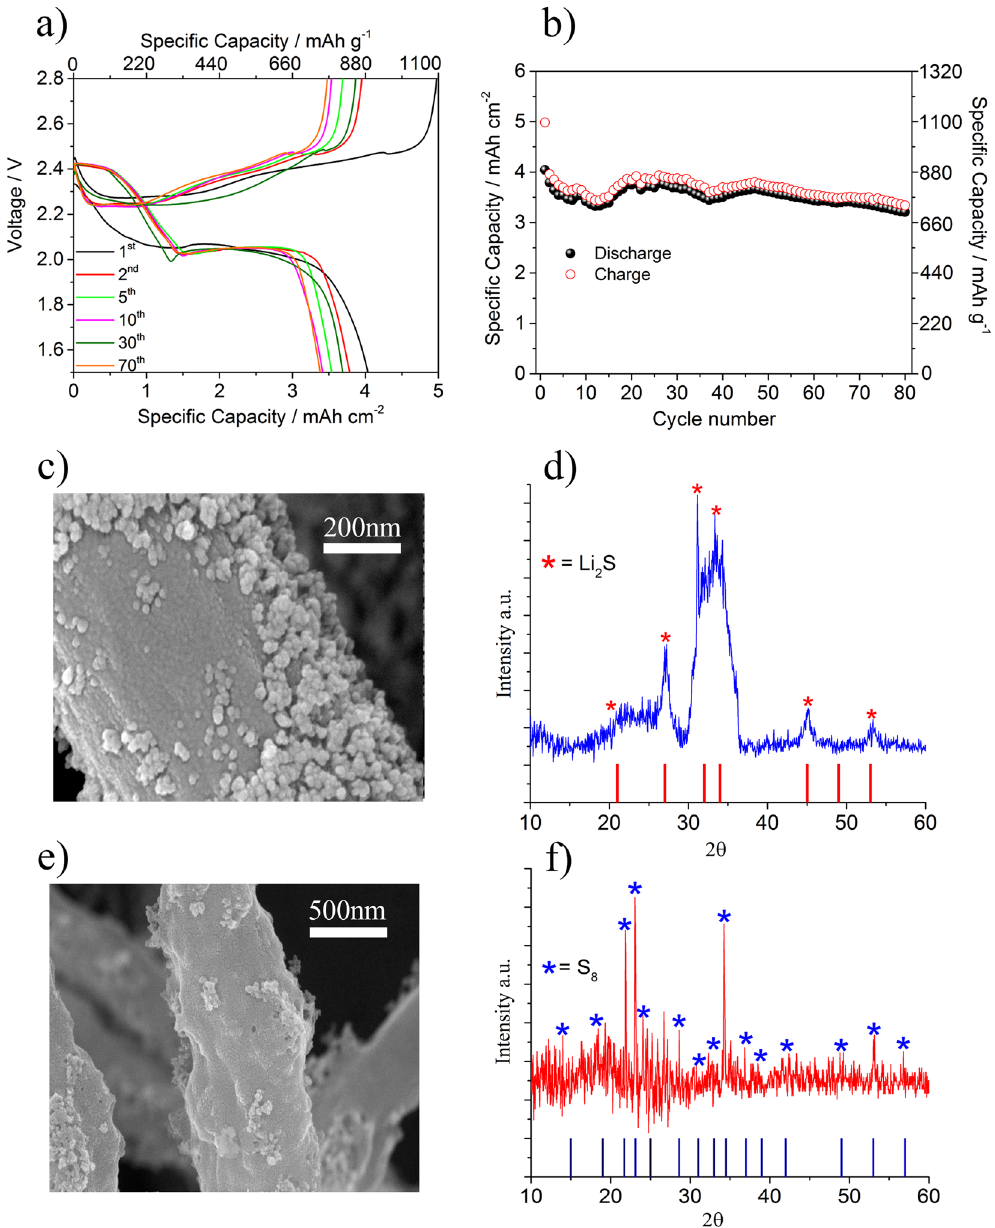
Figure 5. ( a ) Discharge-charge voltage profiles at 1000 μ A cm − 2 for the LiS-cells using the CNF/SiO 2 -HF-KOH membranes and ( b ) capacity as a function of cycle number. ( c ) SEM image and ( d ) XRD- pattern of the CNF/ SiO 2 -HF-KOH membrane after complete discharge. ( e ) SEM image and ( d ) XRD- pattern of the CNF/SiO 2 -HF- KOH membrane after